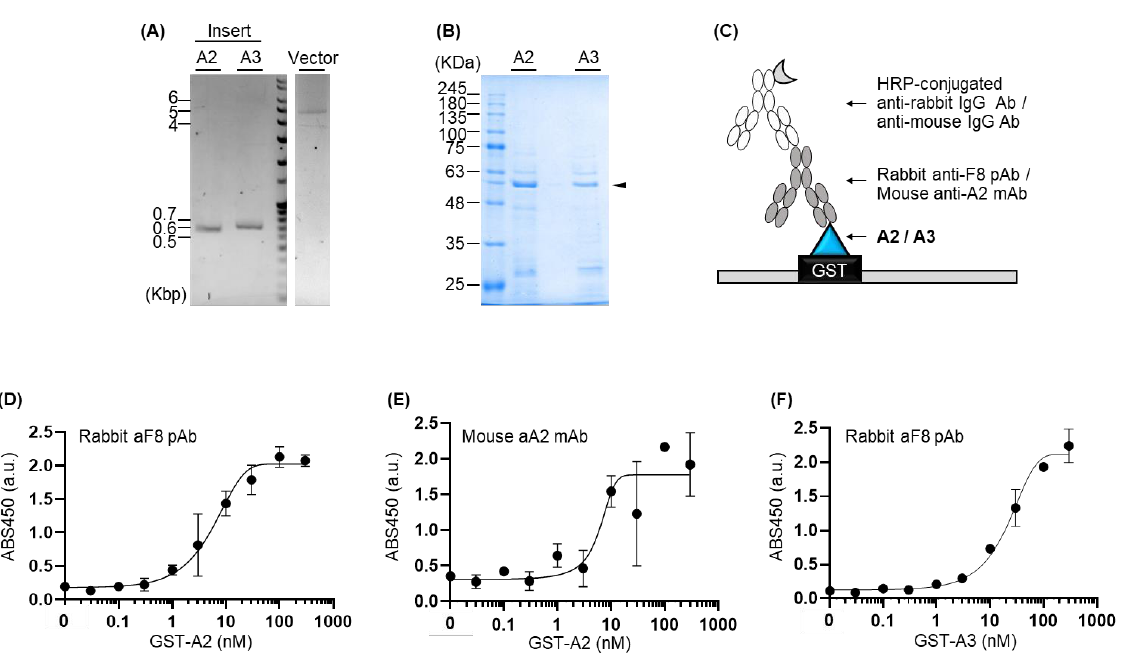
Figure 1. ( A ) Agarose gel electrophoresis analysis of DNA products after amplifying insert DNA (rF8-A2-or rF8-A3-encoding gene) and vector DNA (linearized pGEX-4T1); ( B ) SDS-PAGE analysis of rF8-A2 or rF8-A3. The black arrow indicates the target protein; ( C ) Schematic representation of the ELISA; ( D ) ELISA signal obtained from rF8-A2 with rabbit anti-F8 polyclonal antibody; ( E ) ELISA signal obtained from rF8-A2 with mouse anti-A2 monoclonal antibody; ( F ) ELISA signal obtained from rF8-A3 with rabbit anti-F8 polyclonal antibody. Error bars represent ± 1 SD ( n = 3). SD = stan- dard deviation. GST, HRP, IgG, ABS, pAb, and mAb indicates glutathione S-transferase, horseradish peroxidase, immunoglobulin G, absorbance, polyclonal antibody, and monoclonal antibody, respec-